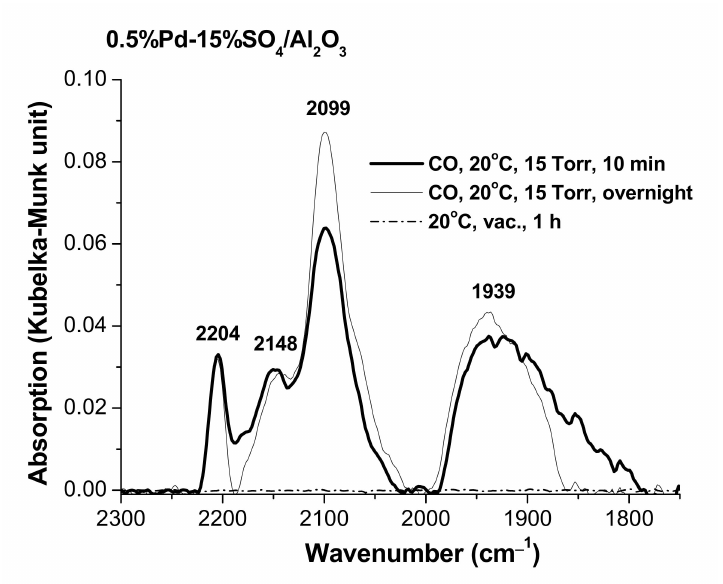
Figure 2. DRIFTS-CO adsorbed on 0.5%Pd-9%H 2 SO 4 /Al 2 O 3